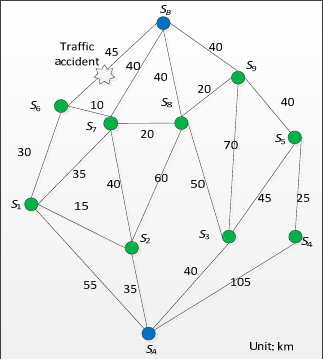
Figure 4. The distance of route segments from A to B .